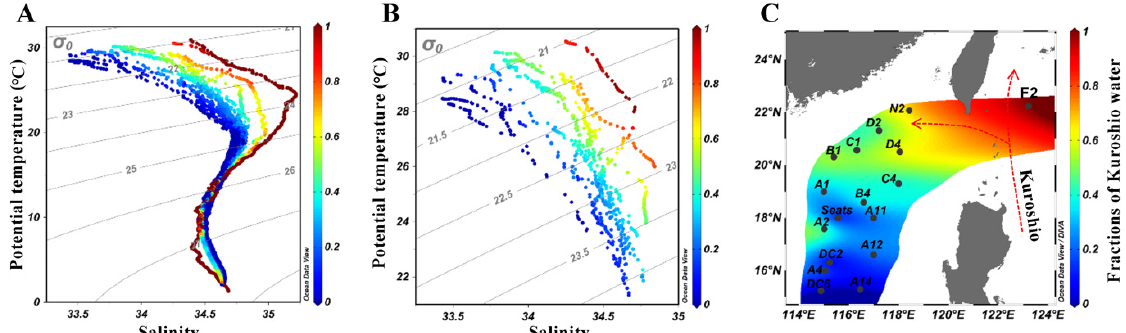
Figure 1. ( A ) The potential temperature versus salinity for the cruise stations in the summer of 2017. The lines in dark red and blue represent the two end-members, i.e., Kuroshio water and South China Sea water. ( B ) Distribution of potential temperature and salinity for sampling stations superimposed by Kuroshio fraction for waters above DCM layer. ( C ) The distribution pattern of average R K (Kuroshio fraction) above deep chlorophyll maximum for sampling